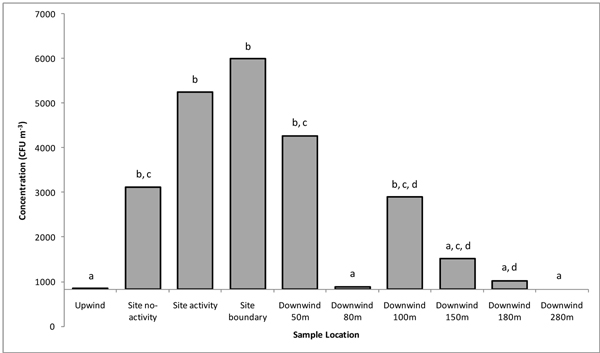
Aspergillus fumigatus concentrations presented in CFU m-3. Bar represents geometric mean, annotations present groups of statistical significance (p =< 0.05). E.g. Within group 'a' there is no statistical difference, while groups 'a' and 'b' are significantly different from each other. X-axis crosses at lower limit of detection, 833 CFU m-3.